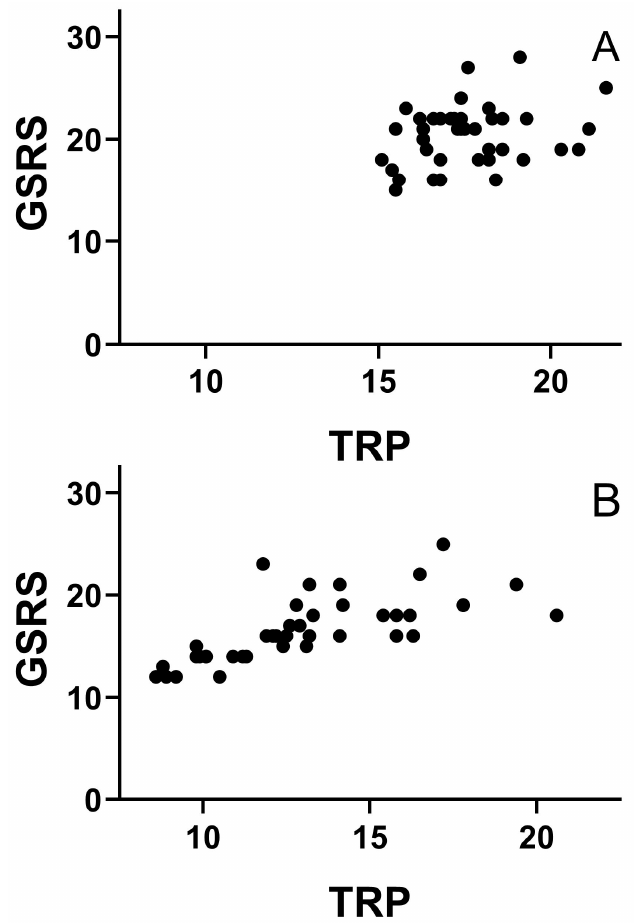
Figure 2. Correlation between daily TRP intake (mg/kg b.w.) and the intensity of abdominal pain (GSRS score) after nutritional treatment of IBS-D patients without ( A ) and with ( B ) an intended reduction in tryptophan intake.